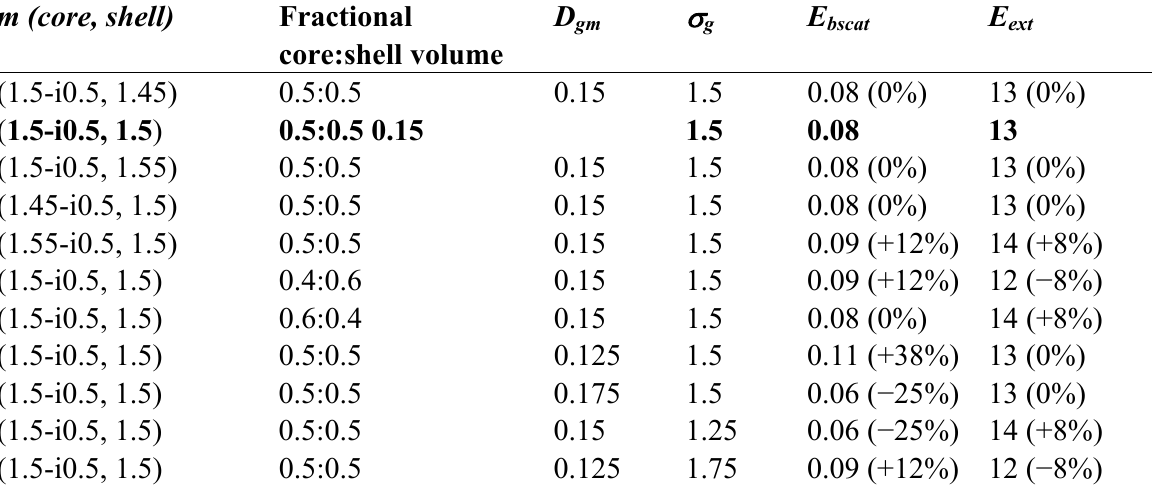
Table 3. Sensitivity of calculated mass efficiencies: diesel